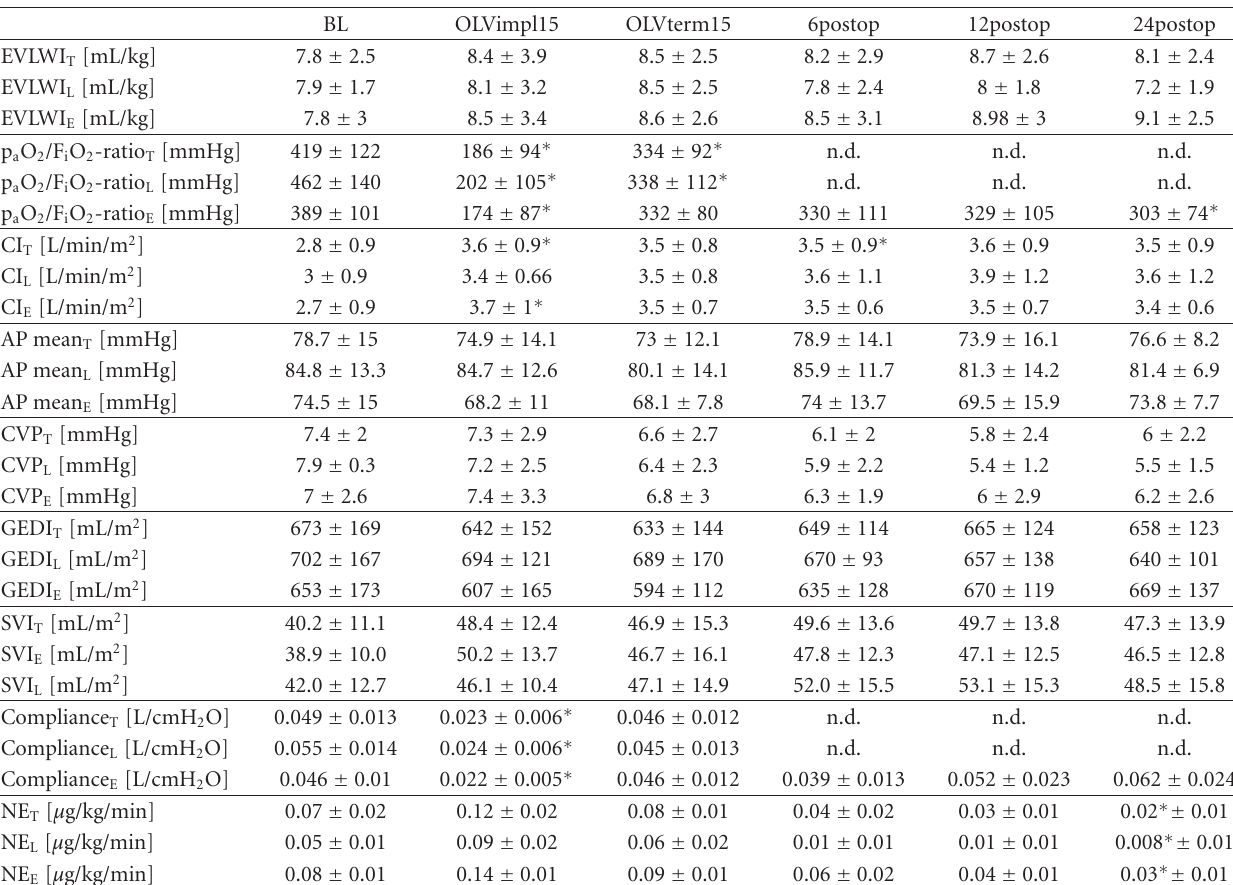
Table 4: Hemodynamic parameters and oxygenation. EVLWI: extravascular lung water index; CI: cardiac index; AP mean: mean arterial pressure; CVP: central venous pressure; GEDI: global enddiastolic volume index; SVI: stroke volume index; compliance: pulmonary compliance; NE: norepinephrine administration; ∗ di ff erence to BL in analysis of variance (ANOVA) ( P < 0 . 05). BL: directly after induction of anesthesia; OLVimpl15: 15 minutes after beginning OLV; OLVterm15: 15 minutes after cessation of OLV; 6postop: 6 hours after